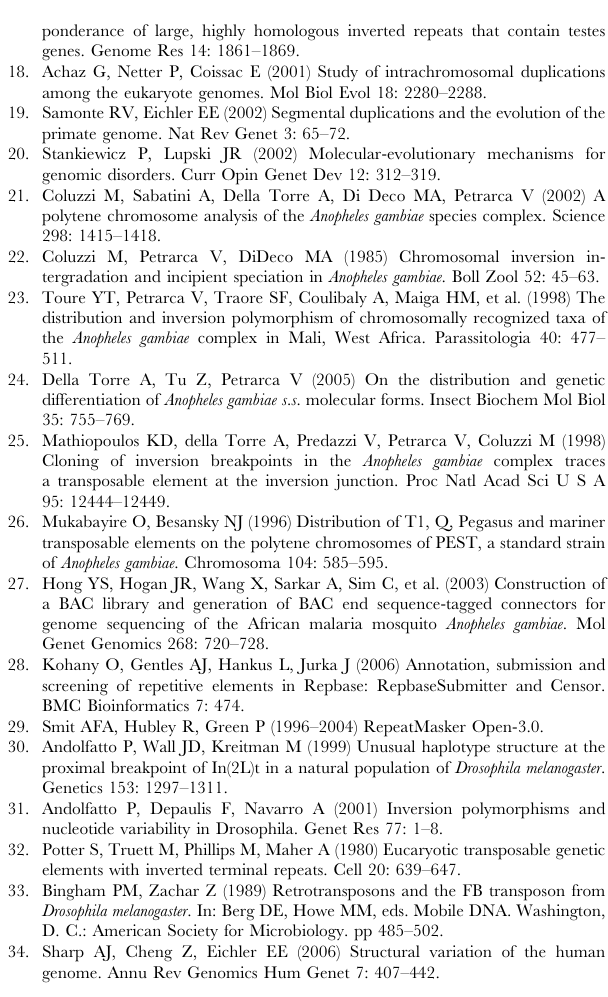
Figure S1 Polymorphic sites at AGAP002110 in A. gambiae field specimens homokaryotypic for 2 Rj